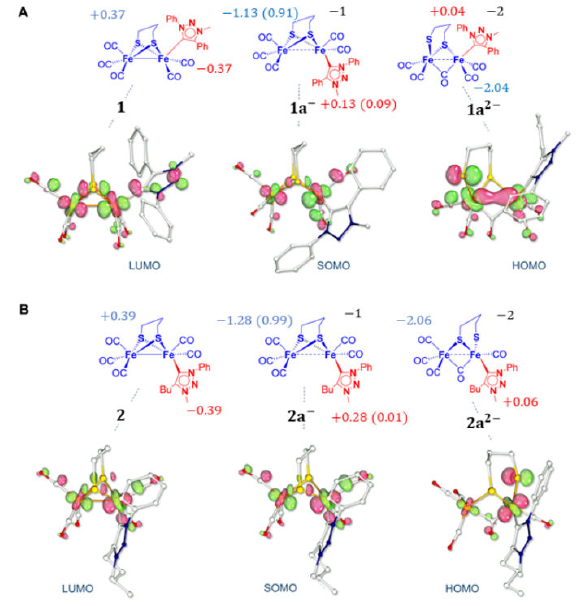
Figure 3. Natural Population Analysis (NPA) charges on the Pmpt ( A ) and Pmbt ( B ) ligands (red values) and on the rest of the complex for most stable neutral, anionic, and dianionic forms of 1 ( A ) and 2 ( B ). Spin densities (in electrons) calculated for 1a − and 2a − are reported in parenthesis. Bottom: Selected FMOs for the three redox states (isosurface cutoff: 0.05